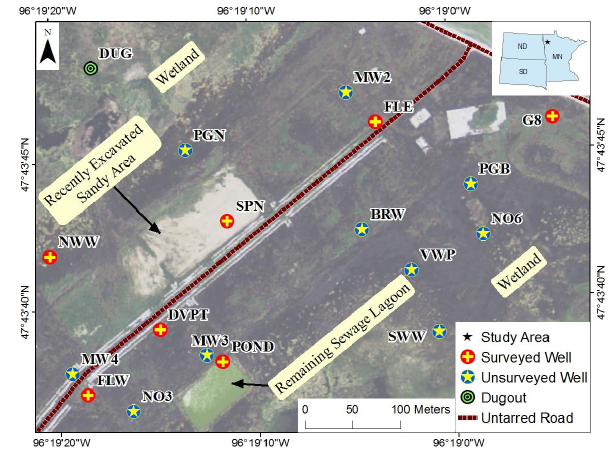
Figure 1. Map of the study area showing the sampled wells and the wetland areas. Fig. 1. Map of the study area showing the sampled wells and the wetland